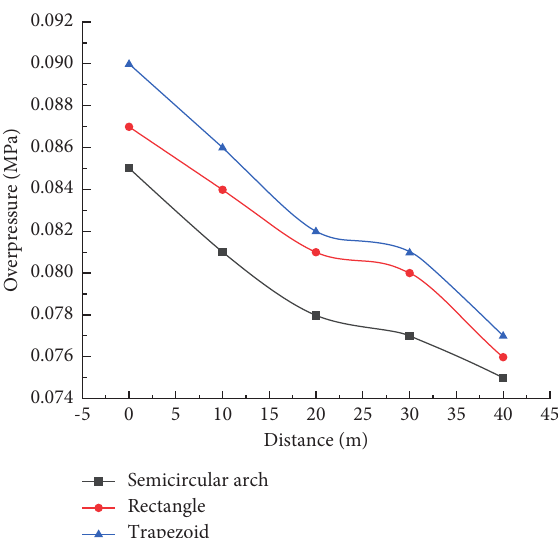
Figure 12: Pressure changes of air inlet tunnel with different cross-sectional